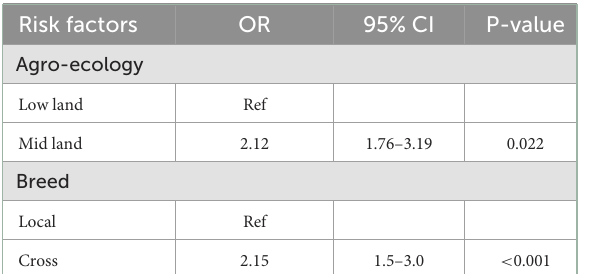
TABLE 3 Univariable analysis of individual level risk factors with ND seroprevalence.